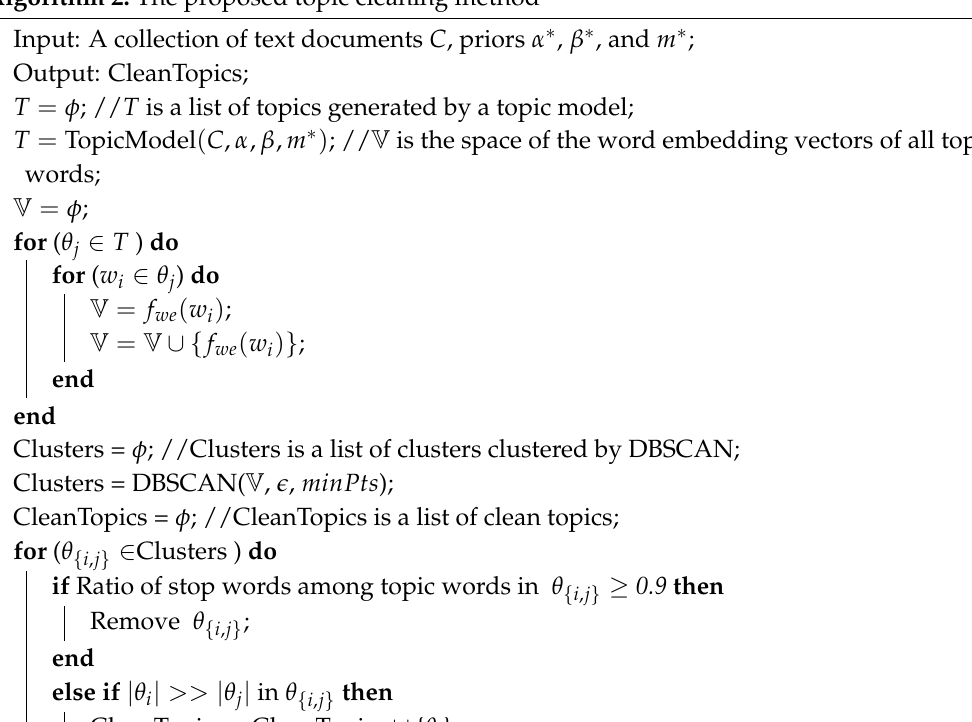
Algorithm 2: The proposed topic cleaning